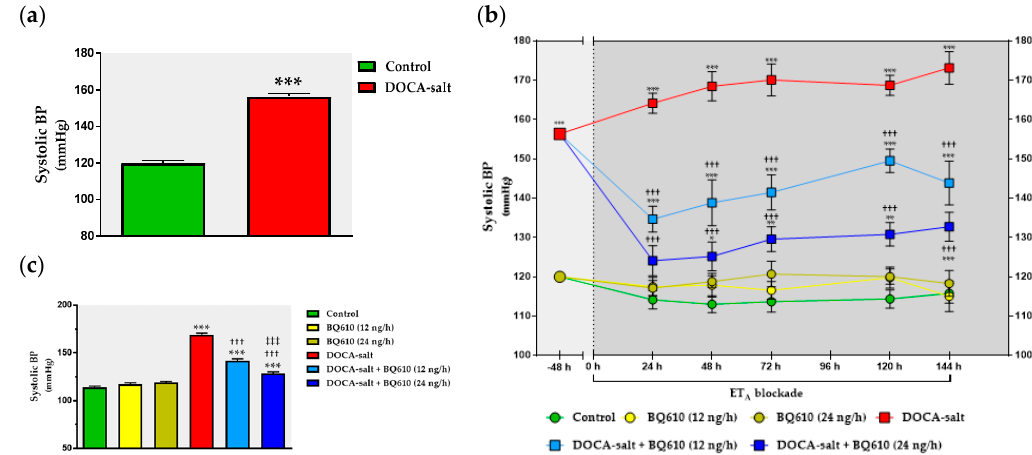
Figure 1. Systolic blood pressure (BP) following ET receptor type A (ET A ) blockade by BQ610 in normotensive and deoxycorticosterone acetate (DOCA)-salt hypertensive rats. Systolic BP was measured by tail-cuff plethysmography as described in Materials and Methods and expressed in mmHg ± SEM. ( a ) Basal systolic BP. Basal values were registered 48 h before BQ610 administration. *** p < 0.001 vs. control. ( b ) Time course of systolic BP . Systolic BP was registered following BQ610 administration at 24, 48, 72, 96, 120, and 144 h. * p < 0.05, ** p < 0.01, and *** p < 0.001 vs. the respective time control; ††† p < 0.001 vs. the respective time DOCA-salt. ( c ) Average systolic BP . Each bar represents the area under each curve (shown in b ) between 0 and 144 h. *** p < 0.001 vs. control; ††† p < 0.001 vs. DOCA-salt; ‡‡‡ p < 0.001 vs. DOCA-salt + BQ610. Number of animals: control, 17; BQ610 (12 ng/h), 12; BQ610 (24 ng/h), 8; DOCA-salt, 17; DOCA-salt + BQ610 (12 ng/h), 11; and DOCA-salt + BQ610 (24 ng/h),